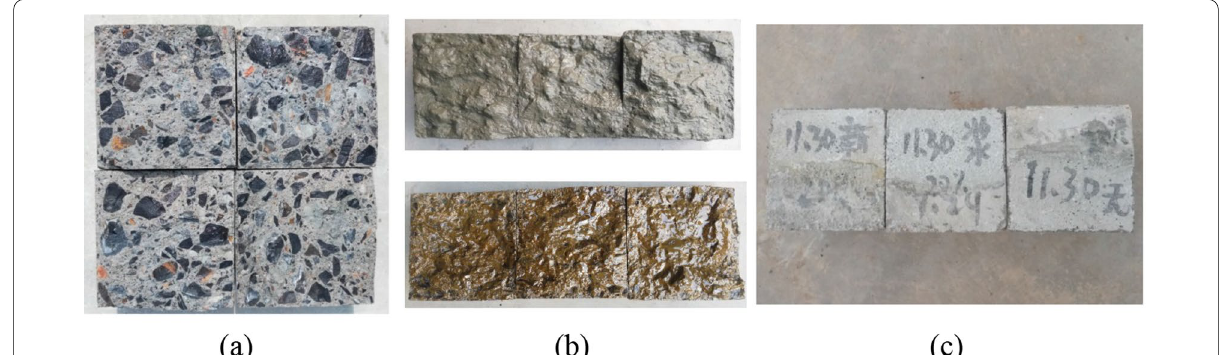
Fig. 5 Bonding specimen preparation process: a cleaned old concrete bonding surfaces; b interface agent‑treated bonding surfaces; c bonding specimens.